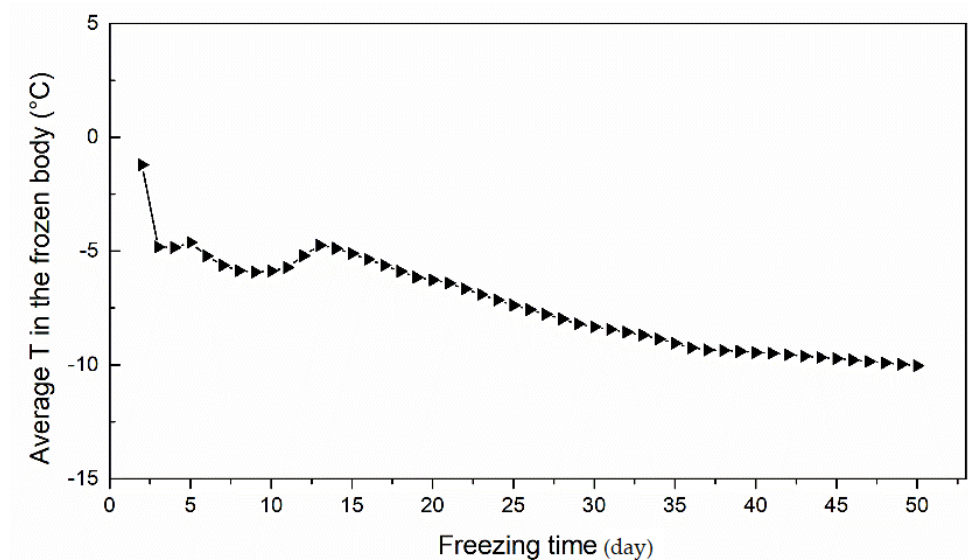
Figure 13. Average temperature curve of the frozen body versus freezing